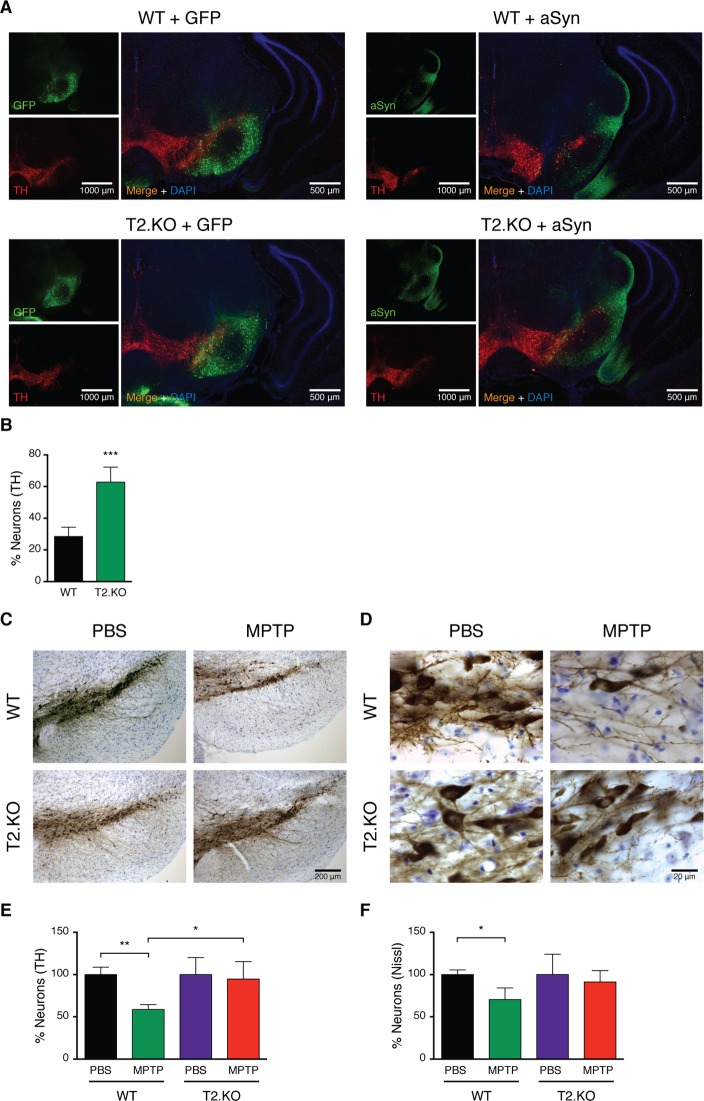
Knockout of SIRT2 protects from aSyn or MPTP toxicity in mice.(A) AAV6-mediated delivery of GFP or WT aSyn into the SN of WT or T2.KO mice brains. TH and GFP or aSyn expression was examined in brain sections 2 wk postinjection by immunohistochemistry (TH, red; GFP or aSyn, green; DAPI, blue). Representative sections are shown. Scale bar for isolated channels 1,000 μm and for merged channels 500 μm. (B) Stereological counting of the number of TH-positive neurons in the SN. The number of TH-positive neurons in the SN of GFP-injected mice was used as control (at least n = 3 per group). Data, presented as percentage of TH-neurons, are average ± SD. *** p < 0.001, unpaired t test with equal SD. Chronic MPTP treatment of WT or T2.KO mice brain. TH (C) or neurons (Nissl) (D) were examined in brain sections 2 wk postinjection by immunohistochemistry (TH, DAB; Neurons, Nissl; DAPI, blue). Representative sections are shown. Scale bar 200 μm. Stereological counting of the number of TH-positive (E) or Nissl-positive neurons (F) in the SN (at least n = 4 per group). Neuron numbers in NaCl-injected mice were used as normalization controls, and data are expressed as percentage of the corresponding NaCl-injected control animals. For (E) and (F), data (presented as percentage of neurons), are average ± SD. * p < 0.05, ** p < 0.01, two-way ANOVA followed by Tukey’s multiple comparisons test. Data in S1 Data.